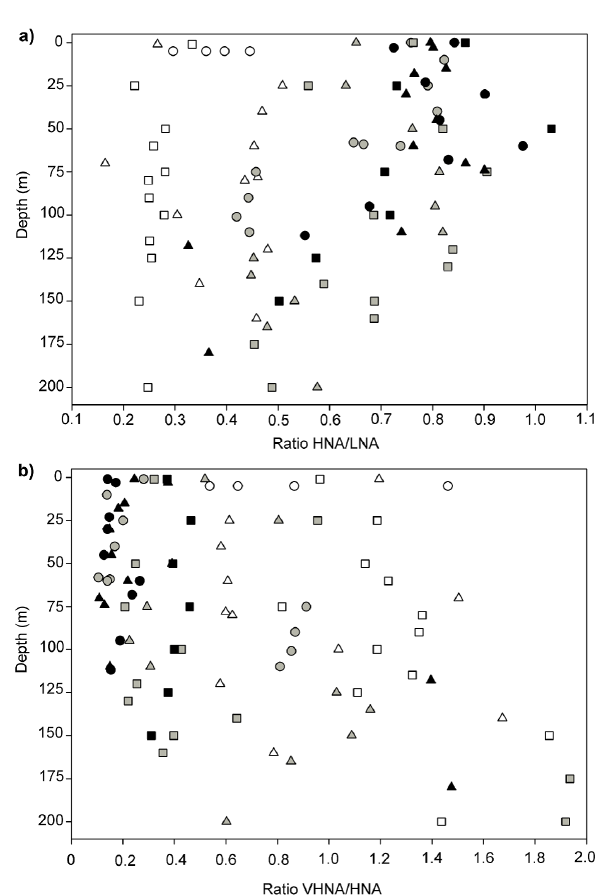
Figure 5. Ratios of the abundances between the heterotrophic prokaryote clusters according to depth. (a) shows the ratio of the abundances of HNA/LNA clusters while (b) shows the ratio of abundances of VHNA/HNA clusters. The white circles are sta- tions 1, 2, 3, and 4. The white triangles and the squares are stations 5 and 6, respectively. The grey circles, triangles, and squares charac- terize stations 7, 8 and 9, respectively. The black squares, circles and triangles are stations 10, 11, and 12,